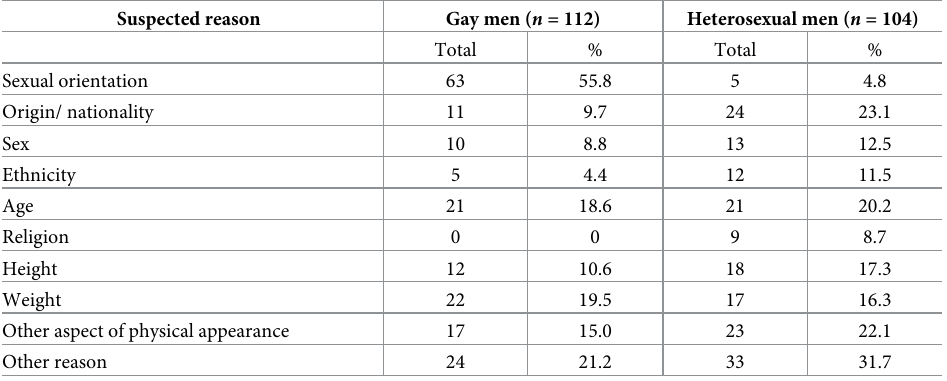
Table 4. Self-rated suspected reason for discrimination as stated in the everyday discrimination experience